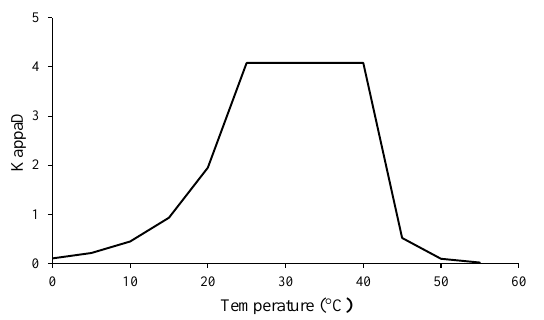
Figure 7. Temperature dependence of the kinetic enzyme variable KappaD used in ForPRAN model simulations (based on theoretical representation of Brock and Madigan, 1991).